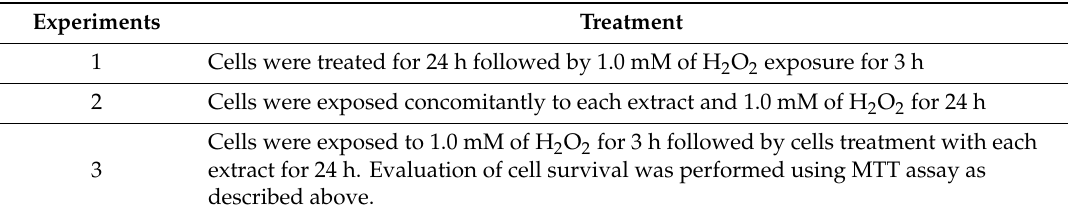
Table 1. Treatment for oxidative stress